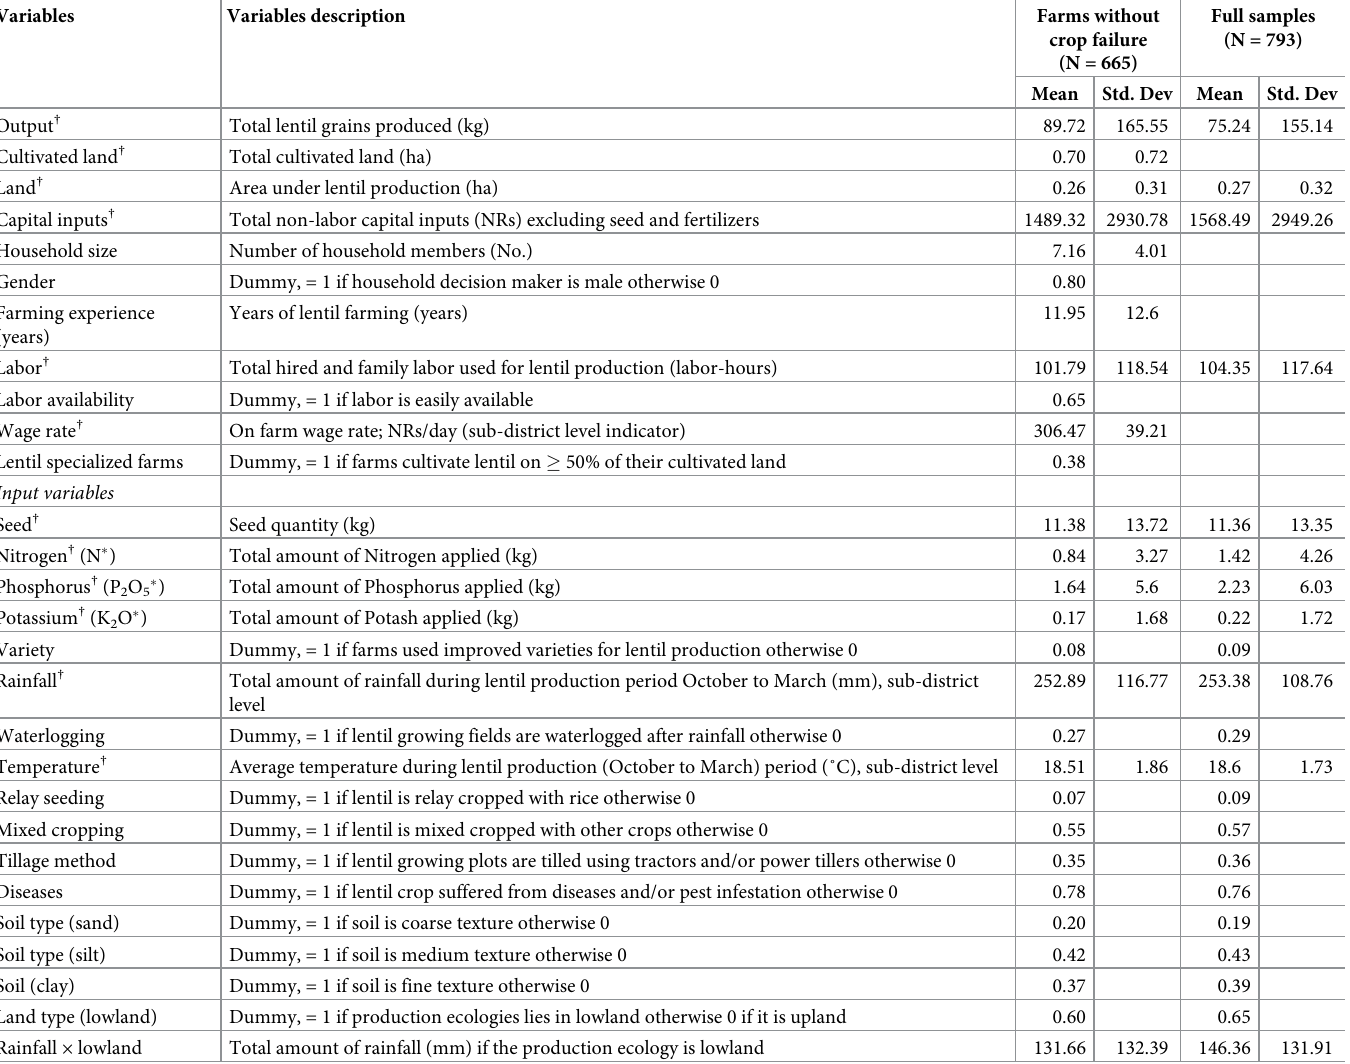
Table 1. Lentil production characteristics and summary